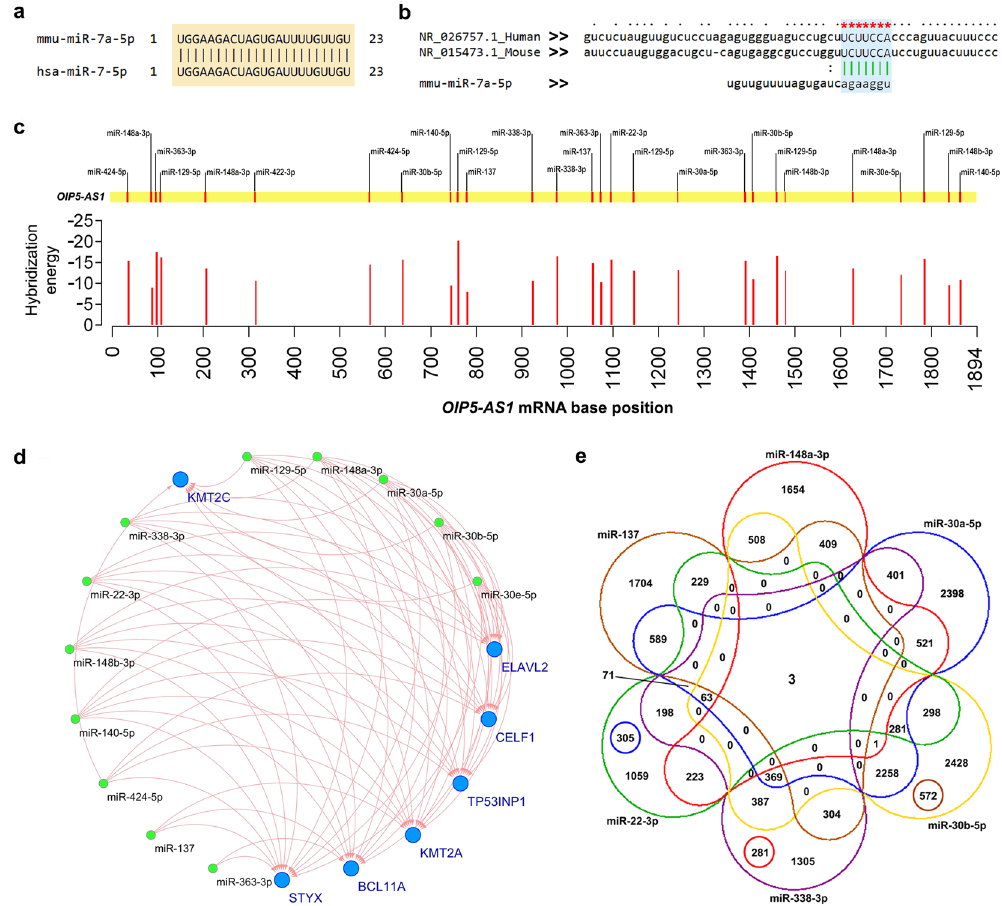
Figure 2. Prediction of miRNA targeted by OIP5-AS1 and possible interactions. ( a ) Nucleotide alignment of mature sequences of mouse mmu-miR-7a-5p (top) and hsa-miR-7–5p (bottom) shows highly conserved. ( b ) Crustal alignment of human OIP5-AS1 (top) and mouse Oip5-as1 (middle) and the interacting site of miR-7 (human/mouse) (bottom). Green lines represent the miRNA seed sequence interaction with the lncRNA and red star indicating the conserved interaction site in human/mouse lncRNA for the candidate miRNA binding. ( c ) Position of predicted miRNA binding sites in the OIP5-AS1 transcript (top) and their corresponding hybridization energy (kcal/mol) with the base position of the seeds (bottom). The full-length transcript of OIP5-AS1 (1894 nt) has multiple interaction sites for the miRNAs. ( d ) Interaction network of predicted miRNAs (nodes in green) and their downstream target mRNAs (nodes in blue). ( e ) Six-set Venn diagram of the miRNAs selected in this study and number of shared mRNA targets. BCL11A, KMT2A and STYX were commonly targeted by all the 6 miRNAs. miR-30a-5p, miR-30b-5p, miR-338-3p and miR-22-3p shared maximum common downstream